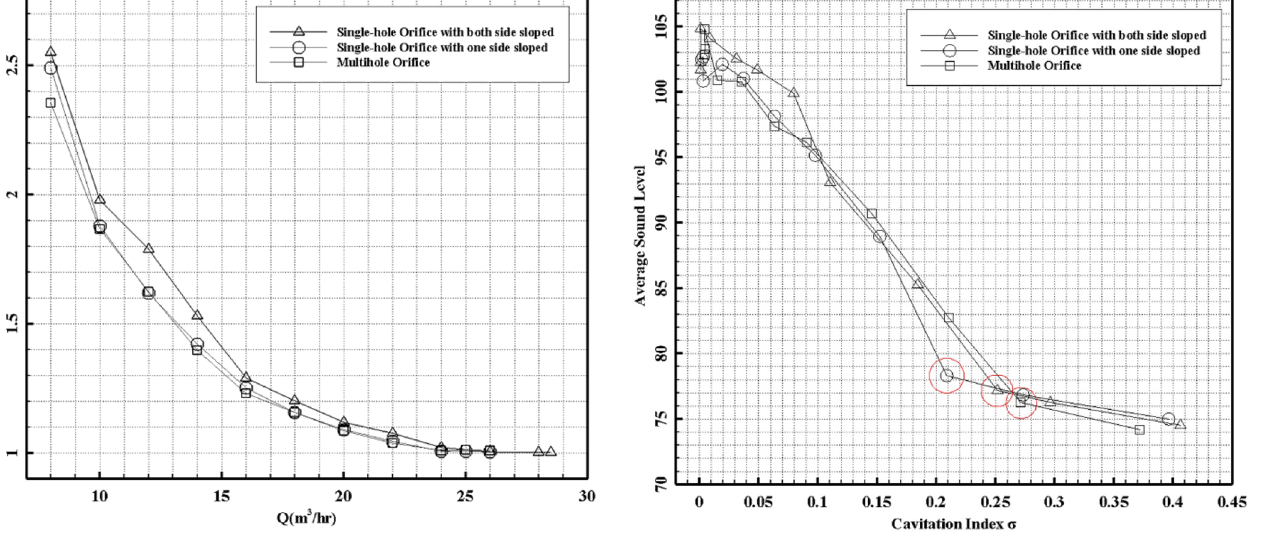
Fig. 15. The trend of ASL with the cavitation index change for different ori fi ces. The horizontal axis is in the logarithmic